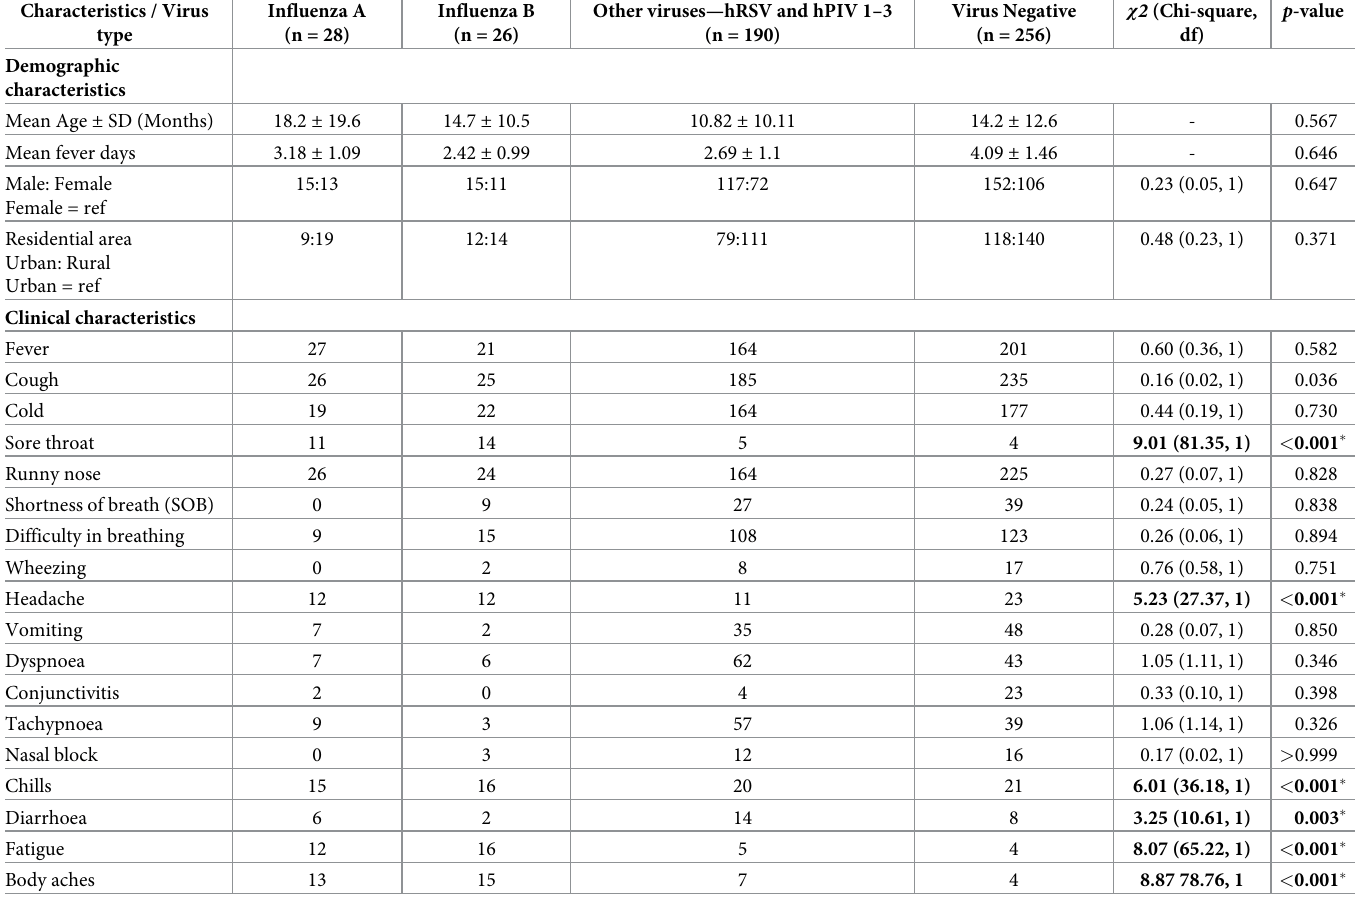
Table 1. Demographic and clinical characteristics of children with Inf-V infections. Characteristics / Virus